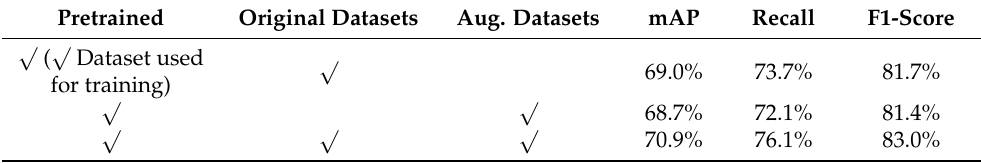
Table 8. Testbed dataset experiment with no group (the input size of the image is 1920 × 1080).